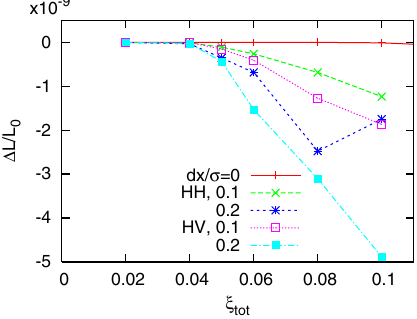
FIG. 4. Luminosity decrement as a function of total beam-beam tune shift for collisions with a horizontal offset equal to 0, 10% and 20% of the rms beam size, and zero crossing angle. The abbreviations “ HH ” and “ HV ” refer to horizontal/horizontal and horizontal/vertical offsets, respectively.